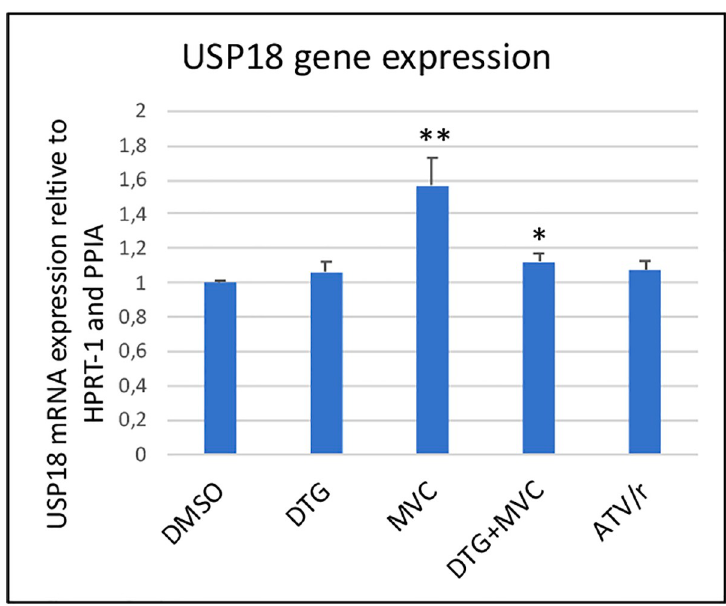
Fig 4. Gene expression of USP18 in the presence of the antiretrovirals. USP18 mRNA level was analyzed by RT-PCR. Two housekeeping genes were used, HPRT-1 and PPIA. The histograms represent the mean+/-SEM value as compared to the DMSO control set at 100% of 3 independent experiments. The comparisons used Welch’s correction of Student T-test. � p < 0.05, �� p < 0.01 versus control (DMSO).